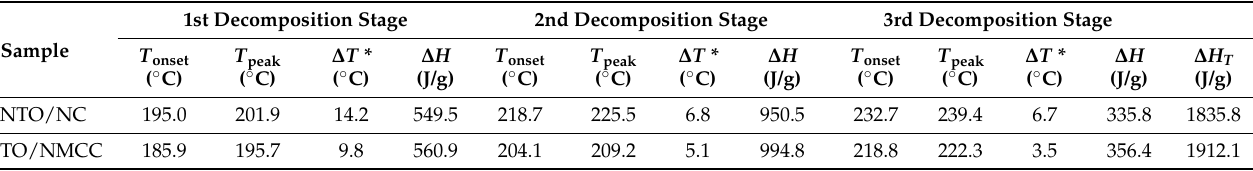
Table 2. DSC parameters of the as-prepared energetic composites obtained at β = 10 ◦ C/min.